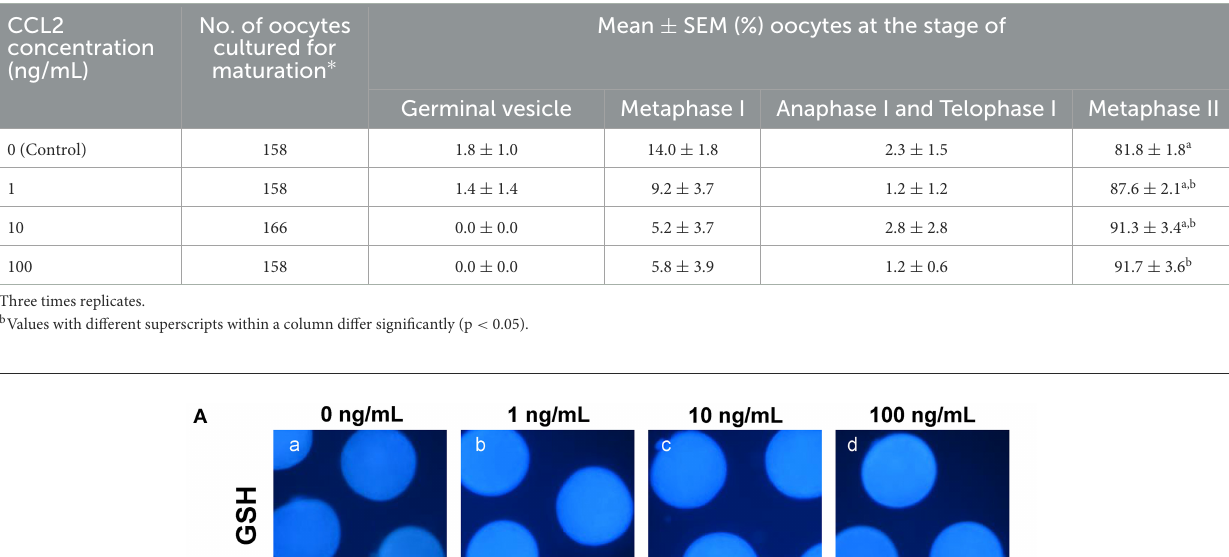
TABLE 2 Effect of CCL2 supplementation during IVM on nuclear maturation.